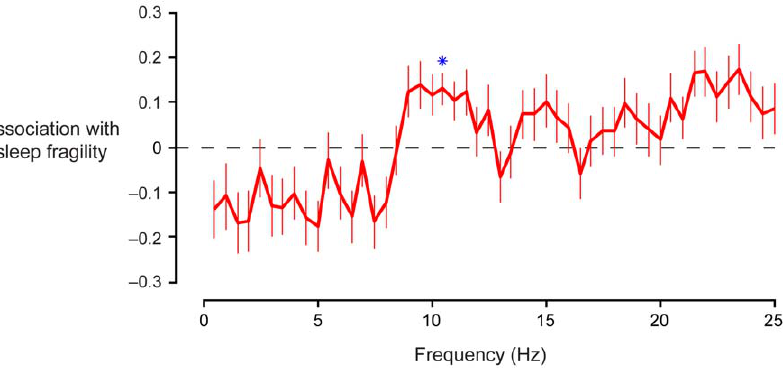
Figure 4. Alpha band power is a specific marker of sleep depth. We examined the broader relationship between EEG spectral content (beyond sleep stage designation) and NREM sleep depth. The power expressed over occipital electrodes immediately preceding each stimulus was standardized using a baseline waking spectrum and the dynamic range observed during sleep at each frequency. The relationship between spectral power values and sleep fragility was then assessed independently with Cox regression; the resulting regression coefficients ( 6 SE) are shown for each frequency in 0.5 Hz bins. Coefficients less than zero imply an association with sleep stability (resistance to disruption), whereas coefficients greater than zero imply an association with sleep fragility (vulnerability to disruption). We observed a strong relationship between heightened sound sensitivity and spectral power throughout the alpha band. Trends toward sleep stability emerged in conjunction with low frequency ( , 8 Hz) power and toward fragility in conjunction with high frequency ( . 13 Hz) power. * P , 0.05 after correction for multiple comparisons.